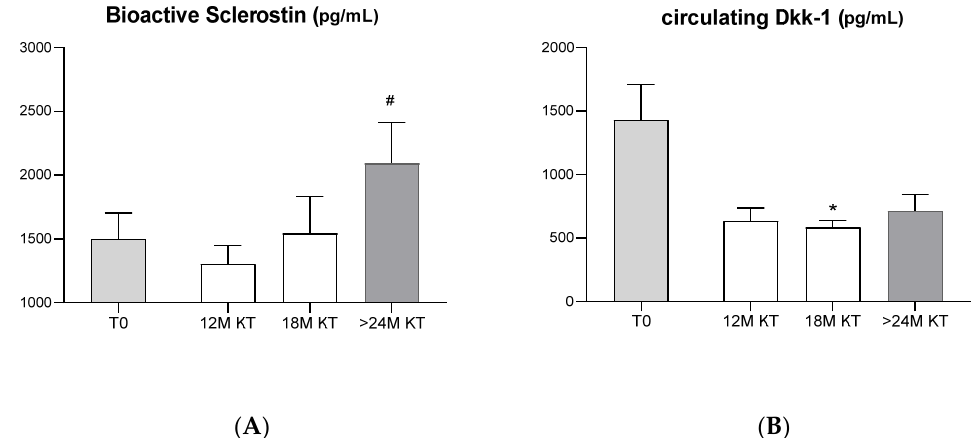
Figure 1. Circulating levels of bioactive Sclerostin ( A ) and Dicckopf-1 ( B ) at baseline (T0 before KT n = 13) and 12 ( n = 6), 18 ( n = 10) and 24 months ( n = 6) after kidney transplantation. * p < 0.05, each time after TX (12, 18 and 24M) versus baseline (T0), and # p < 0.05, 24M after TX versus 12M after TX. Regarding circulating Dkk-1, 18 months after kidney transplant the levels of this bone biomarker suffered a significant reduction (1430 ± 283.1 pg/mL to 584.0 ± 168.2 pg/mL, p = 0.02) and remained reduced during the FW period until 24 months after transplantation (Figure 1B).